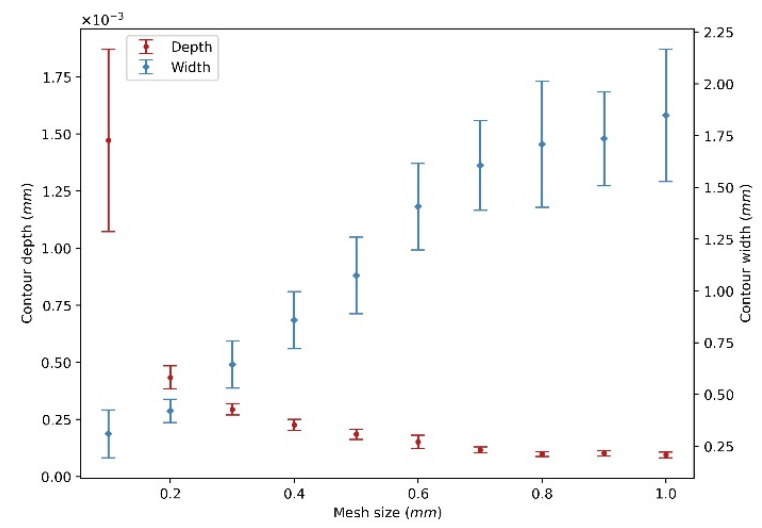
Figure 7. Statistical analysis of wear depth and width.